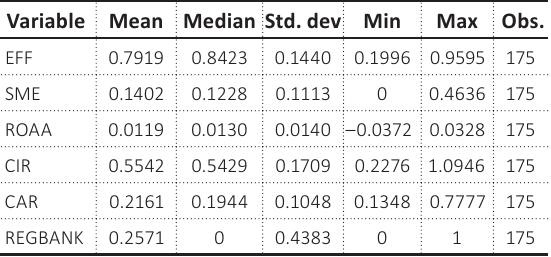
Table 5. Descriptive statistics of the efficiency